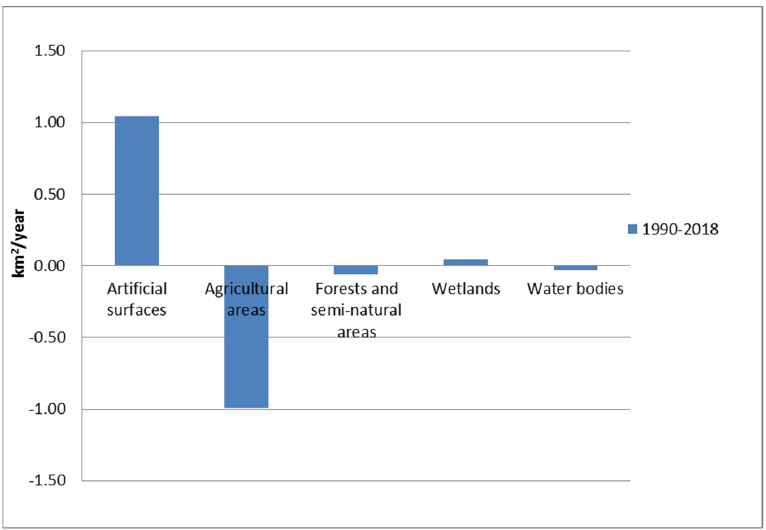
Figure 3. Yearly land take per major land cover category in study area for period